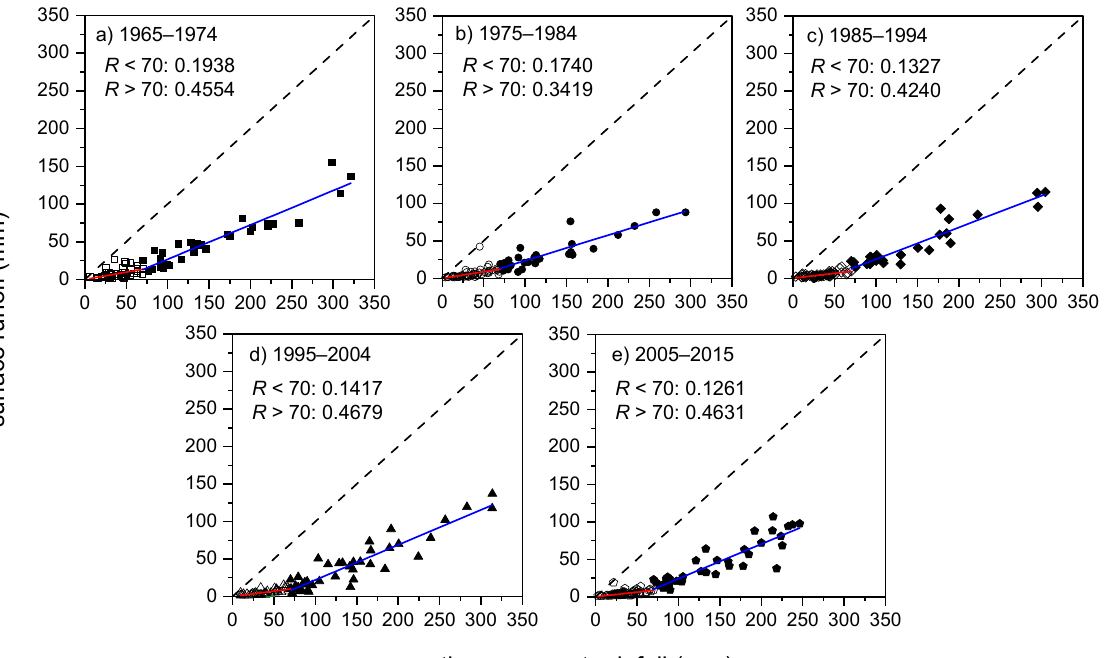
Figure 6. Rainfall–runoff correlation plots in each decade: ( a ) 1965–1974, ( b ) 1975–1984, ( c ) 1985–1994, ( d ) 1995–2004, and ( e )